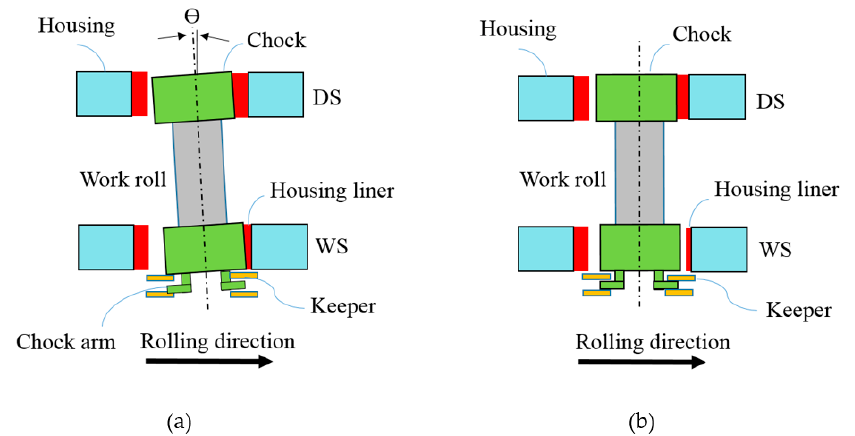
Figure 14. Schematic illustration on misalignment of the work roll influenced by different degrees of axial clearances between keepers and chock arms. ( a ) Loose axial clearance, ( b ) tight axial clearance.